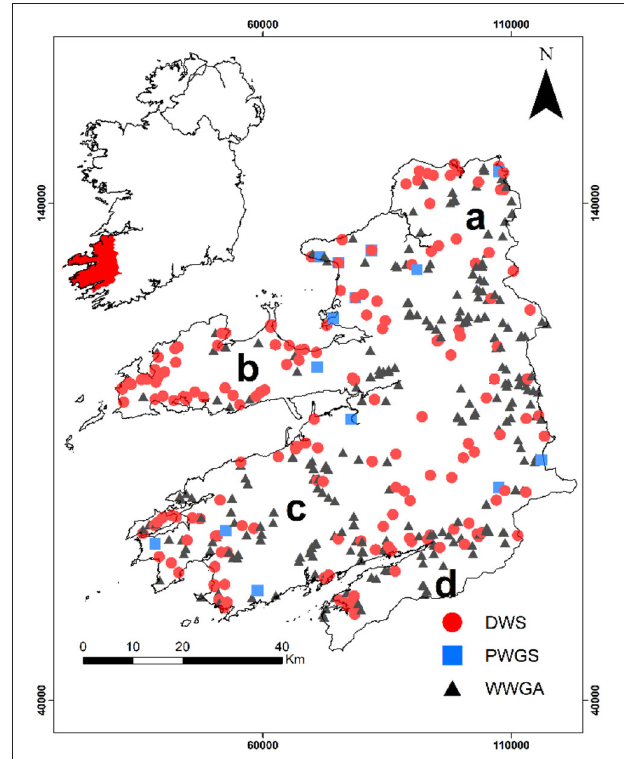
FIGURE 1 | Spatial distribution of monitoring locations in Kerry in relation to the three datasets used in this study (where DWS, drinking water supplies; WWGAs, well water grant applications; PWGS, public water groundwater sources) and regions (where a = northern area of study site, b = Dingle Peninsula, c = Iveragh Peninsula, and d = Beara